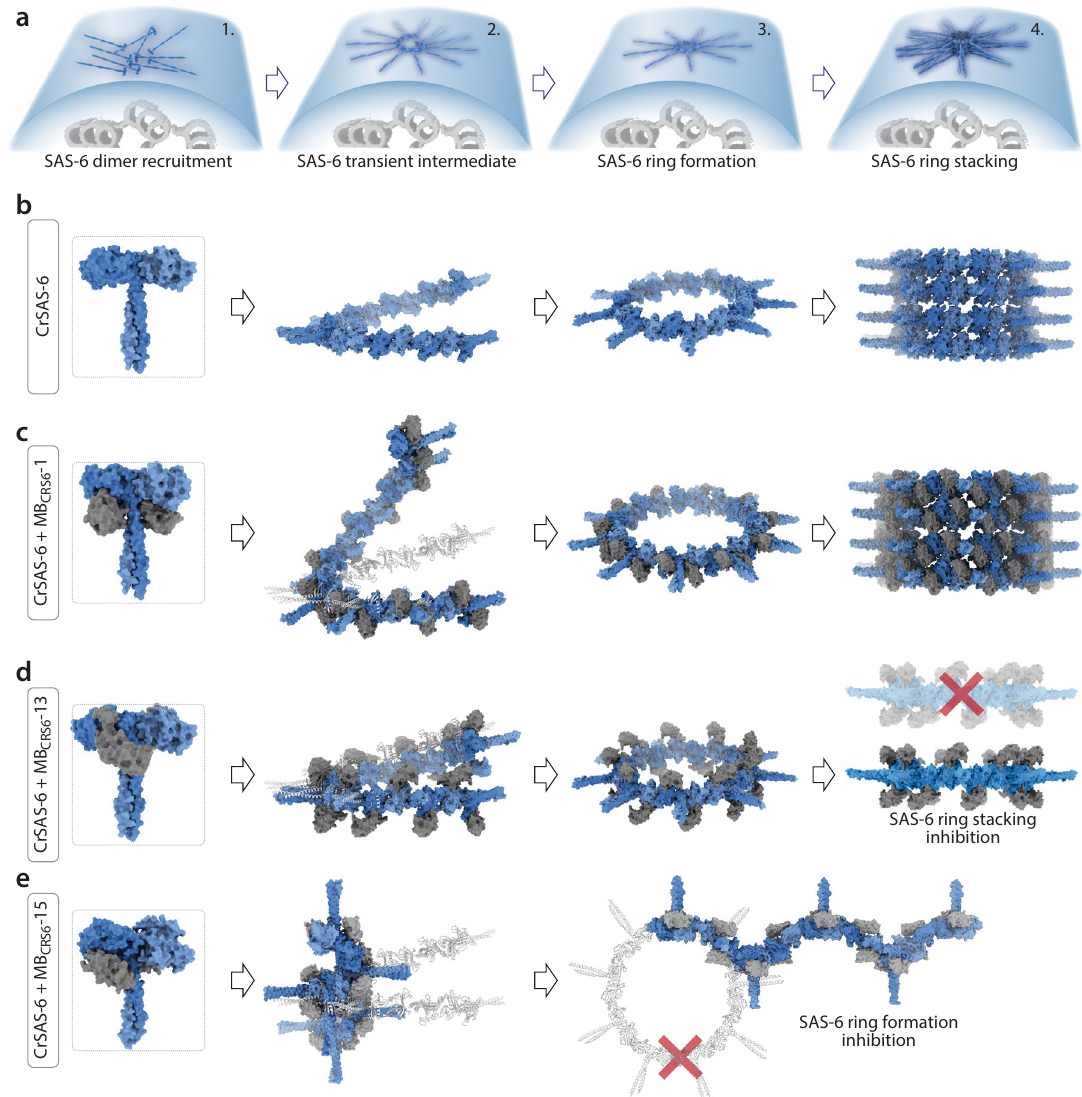
Fig. 5 Monobodies against CrSAS-6 impair distinct steps of the assembly reaction. a, b Schematic of procentriole formation in normal conditions. SAS-6 is recruited to a torus surrounding the resident centriole (1, curved blue surface, part of resident centriole viewed in cross section), where procentriole assembly begins by SAS-6 homodimers polymerizing into higher order oligomers, including a postulated intermediate helical state (2), which then closes into a ring polymer (3). Thereafter, such ring polymers stack, forming the cartwheel element at the root of centriole assembly (4). c – e Model of the consequences of monobody binding for the SAS-6 assembly reaction. MB CRS6 -1 induces an intermediate state with a higher pitch, which leads to ring polymers with a slightly higher mean diameter ( c ); MB CRS6 -13 is positioned above and below the plane of the SAS-6 ring polymer, which interferes with stacking ( d ); MB CRS6 -15 causes a drastic conformational shift leading SAS-6 to polymerize into a helix with a fourfold screw axis, which prevents ring polymer formation (~1 – 4 weeks). Thereafter, the DNA of the selected monobodies was isolated, and loops were PCR ampli fi ed with extension primers in preparation for yeast display selection. Yeast cells were transfected with ampli fi ed loop fragments and with a yeast vector backbone for homologous recombination (~1 week). Several rounds of yeast display were then performed by sequentially lowering the concentration of the target until only a few clones were left in the pool, and lower concentration of target no longer led to clones with better af fi nity (~2 – 4 weeks). Single clones were plated on CAA-agar plates and monobody DNA fragments isolated by colony PCR before sequencing. Yeast display was performed using antibodies to detect the V5 tag of the monobodies displayed on the yeast surface, and Streptavidin-Dylight650 or Neutravidin-Dylight650 to detect binding to the biotinylated target. Nine of the 14 monobodies thus selected could be puri fi ed in suf fi ciently high yield to be tested using the cryo-EM stacking assay (see below). Seven of these exhibited decoration on the outside of the SAS-6 stack of rings, as exempli fi ed by MB CRS6 -1, whereas MB CRS6 -13 and MB CRS6 -15 did not exhibit such decoration. Two of the 7 monobodies that exhibit decoration on the outside were processed for crystallization trials, but only MB CRS6 -1 gave diffracting crystals.